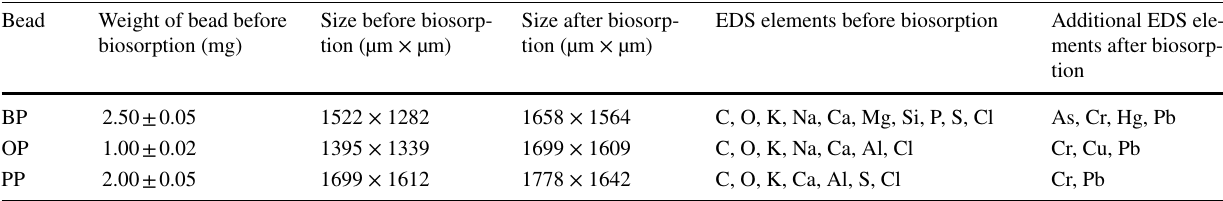
Table 3 Summary of SEM–EDS analysis of the beads hBead Weight of bead before biosorption (mg)